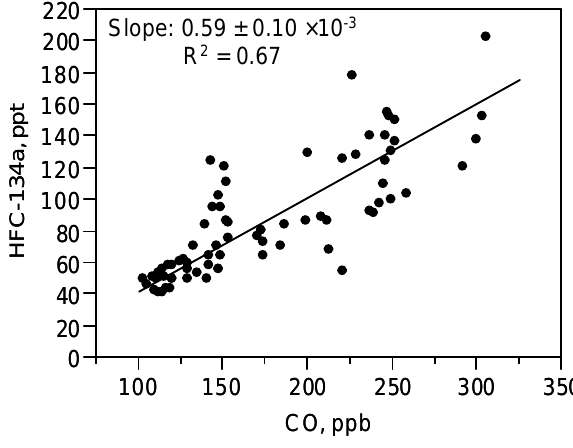
Figure 6. Mixing ratios (ppt) of (a) HFC-152a and (b) HFC-134a measured over the SoCAB (boundary indicated by the solid gray line). The samples included within the red dotted line are the data points used to calculate emissions from the LA County. Downtown Los Angeles is indicated by the red star.